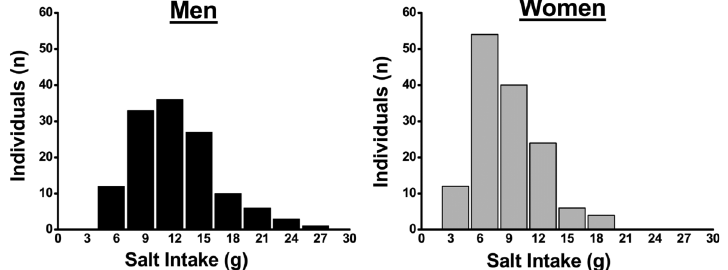
Figure 1. Distribution of salt intake by